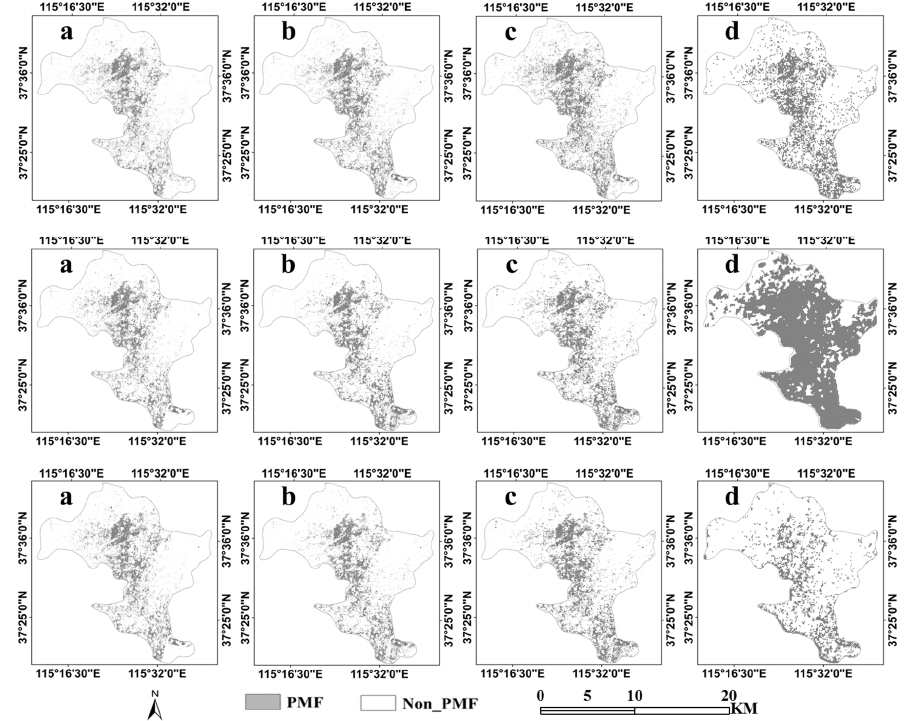
Figure 7. Spatial distribution of PMF in Jizhou (PMF extracted from Support Vector Machine (SVM) using spectral features, textural features and combined spectral and textural features from top to button, respectively at the spatial resolution of 6 m, 64 m, 100 m and 250 m from left to right).